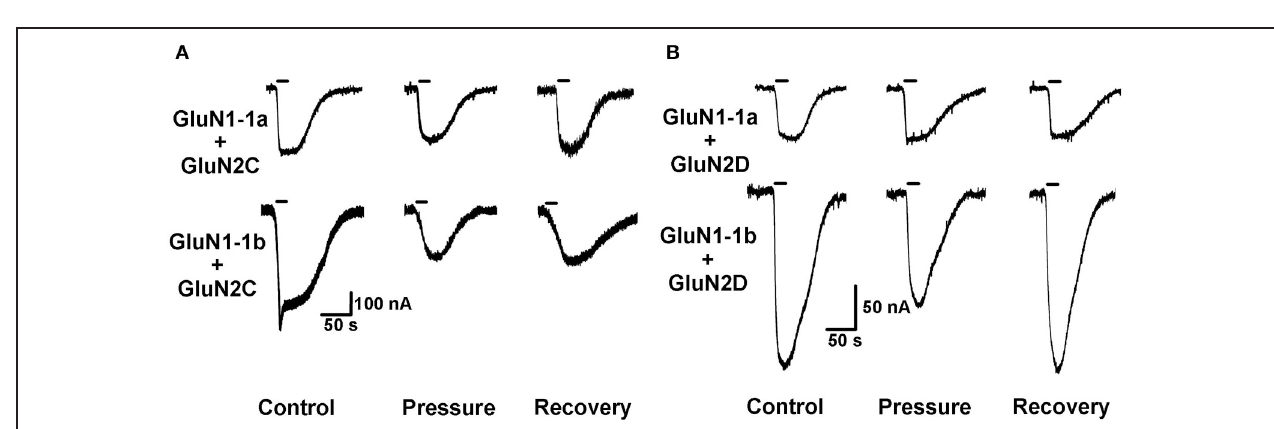
FIGURE 3 | HP effects on GluN2C and GluN2D NMDAR subtypes. (A) HP differentially modulates GluN2C subtype currents. Top: HP moderately decreases GluN1-1a + GluN2C current. Bottom: HP greatly decreases GluN1-1b + GluN2C current. Note only partial recovery of the response. (B) HP selectively modulates GluN2D subtype currents. Top: GluN1-1a +